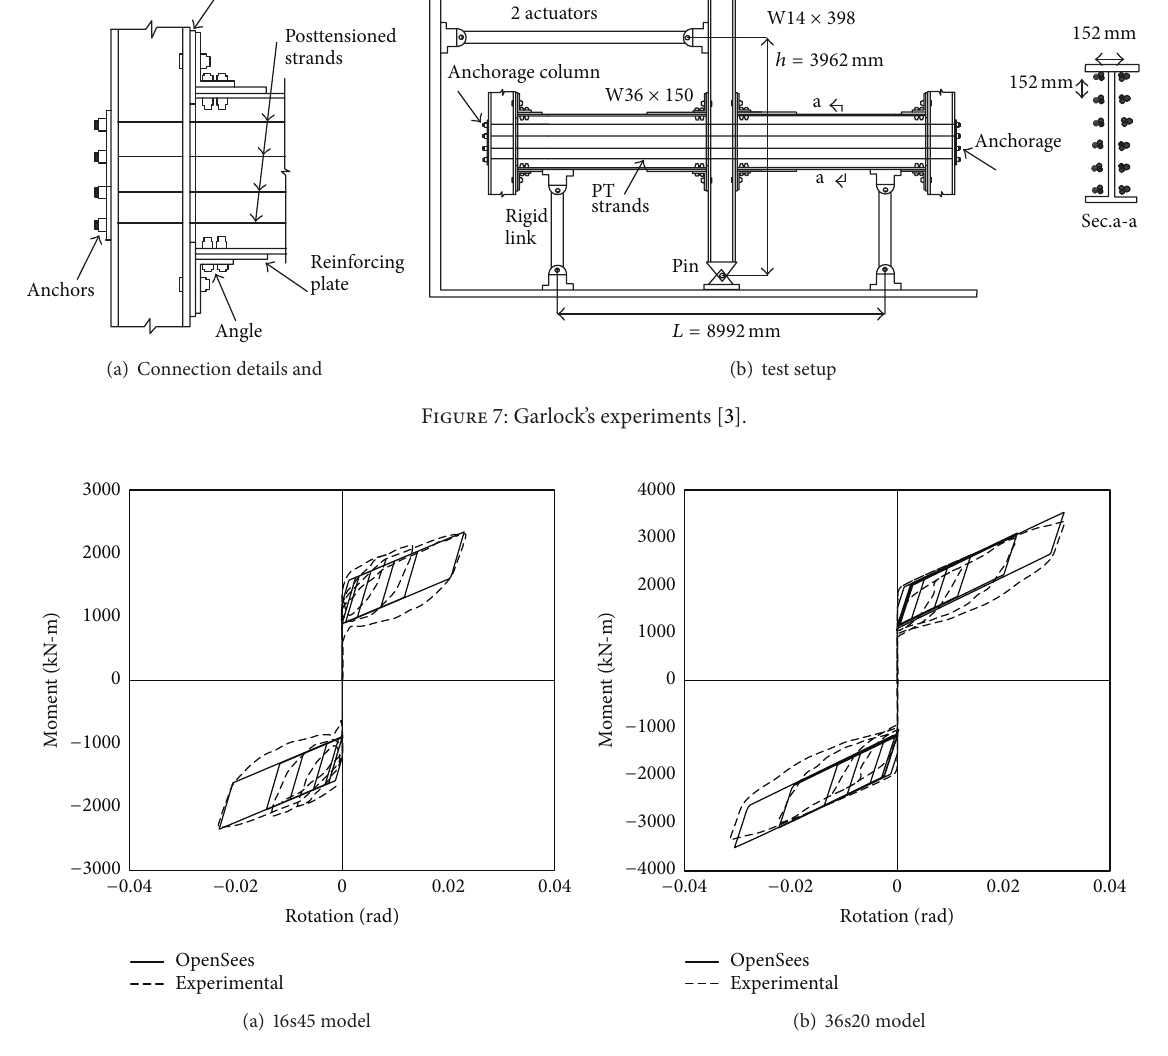
Figure 8: OpenSees and experimental